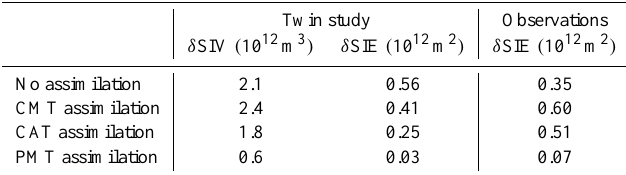
Table 1. Average assimilation error after Eq. (12) for annual mean Arctic ice volume and extent in the twin study (first and second column; cp. Fig. 1) and for annual mean Arctic ice extent when compared to observations (third column; cp. Fig.